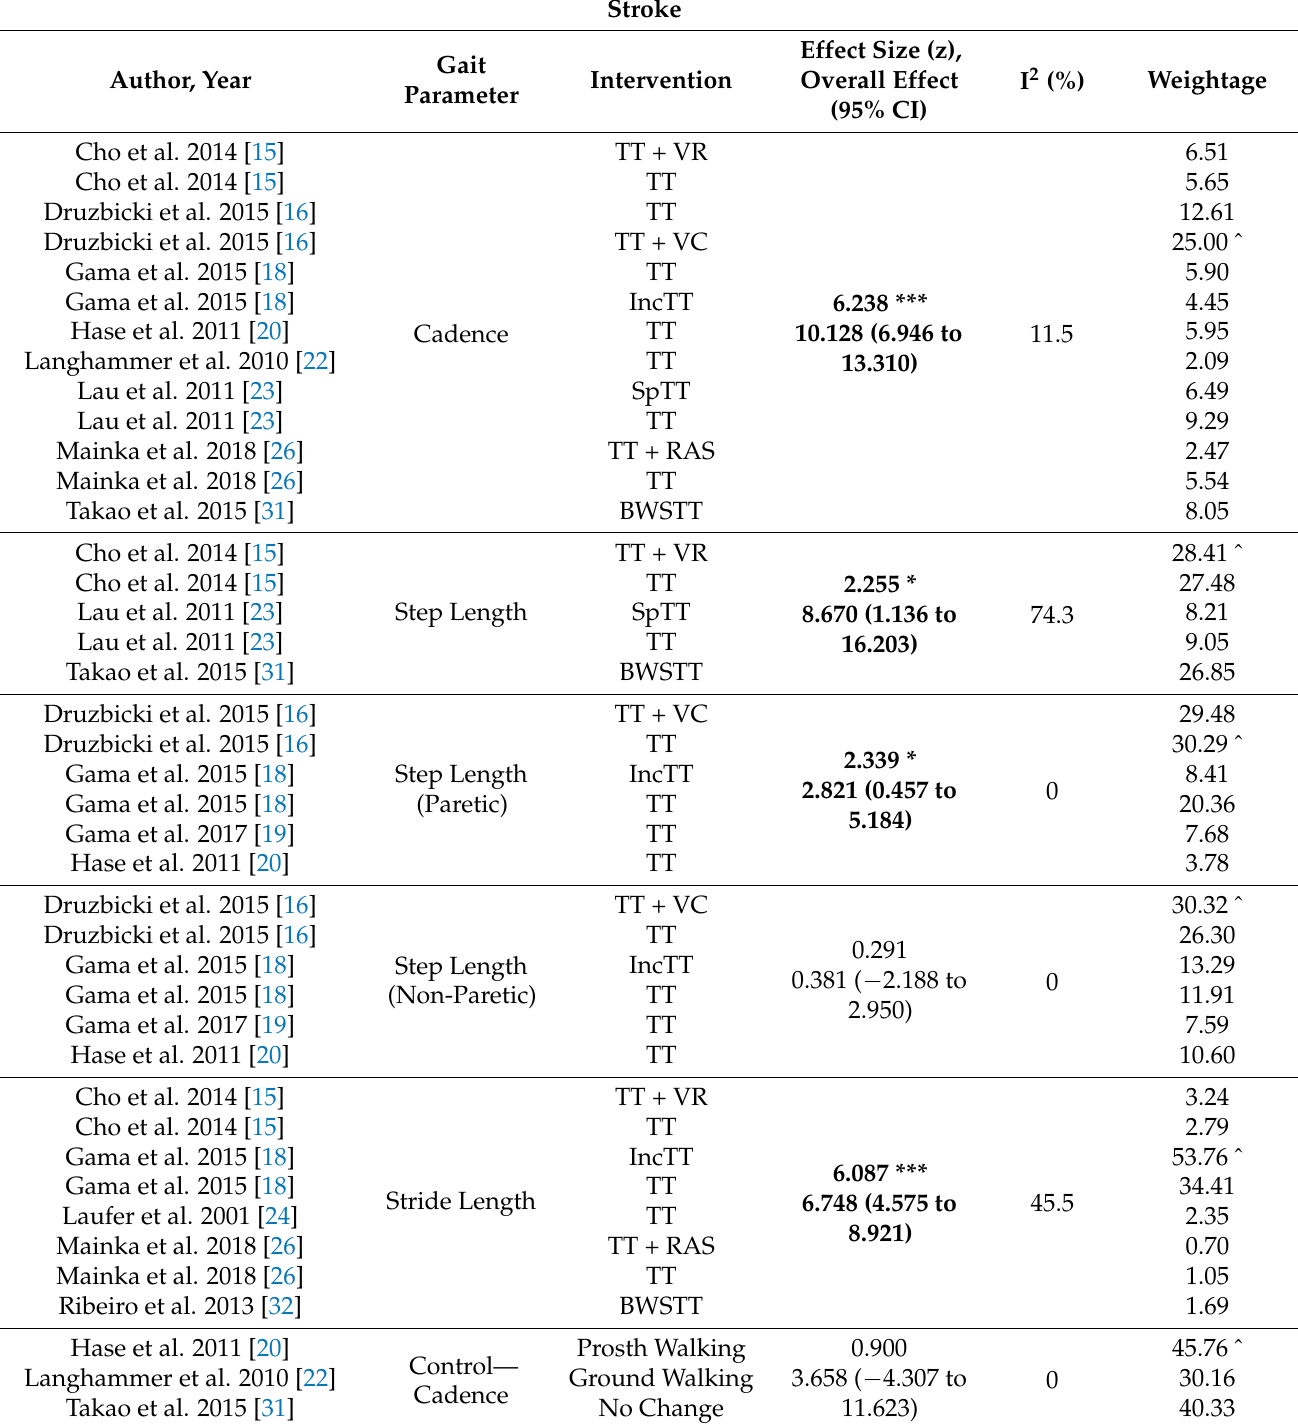
Table 2. Meta-analysis in people with